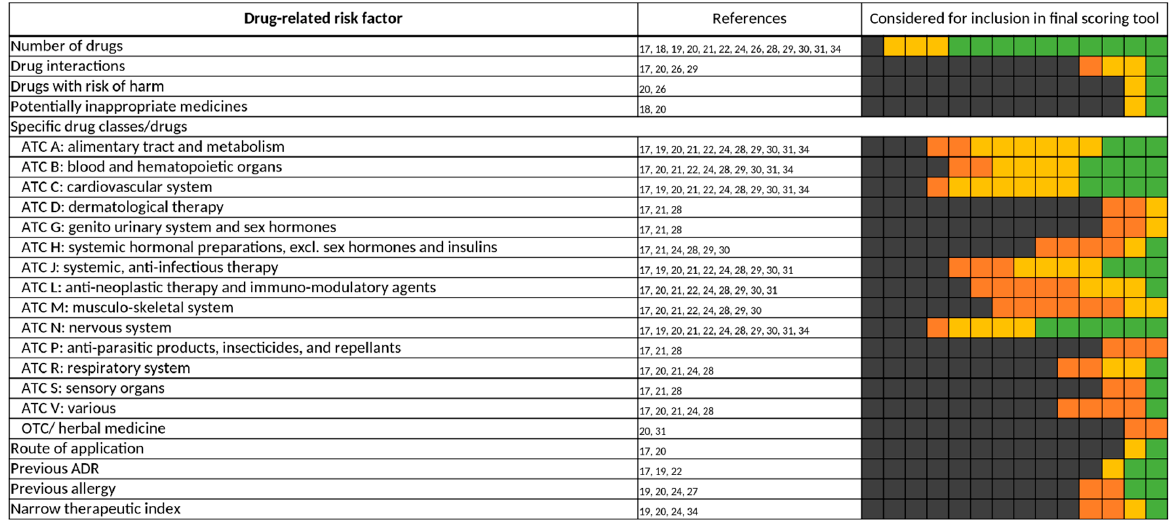
Figure 3. Drug-related risk factors. Specific drugs and drug classes were assigned according to their respective Anatomical Therapeutic Chemical (ATC) Classification System codes. ADR, adverse drug reaction; OTC, over-the-counter. Each of the 14 boxes represents one of the included studies. The color of the boxes portrays whether a risk factor was not investigated in a study (gray), was investigated (orange), was significant in a first statistical analysis or based on expert consensus and therefore tested for inclusion in a final scoring tool (yellow), or whether a risk factor was included in a final scoring tool (green). The “citations”-column lists each study that at least investigated the respective risk factor.